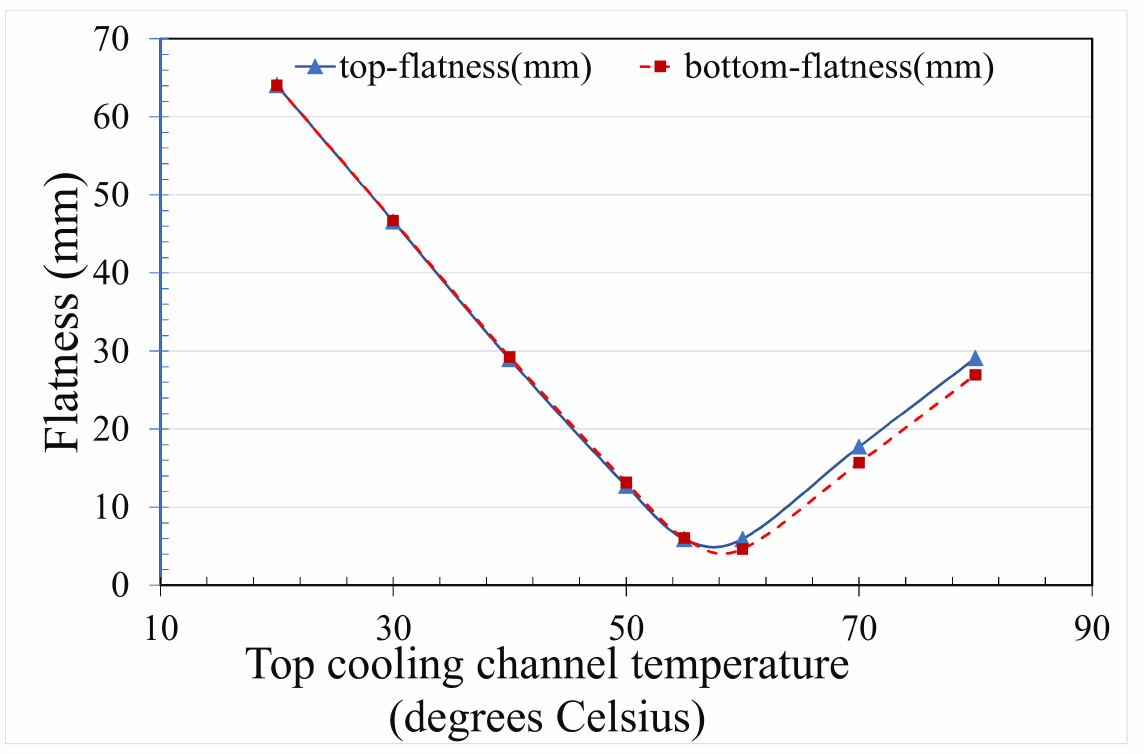
Figure 7. Numerical flatness with respect to the cooling channel of the cavity plate under the pre-set sequential valve gate-opening scheme (20 ◦ C cooling channel within the core